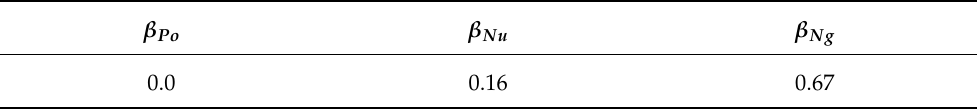
Table 6. Aggregated belief